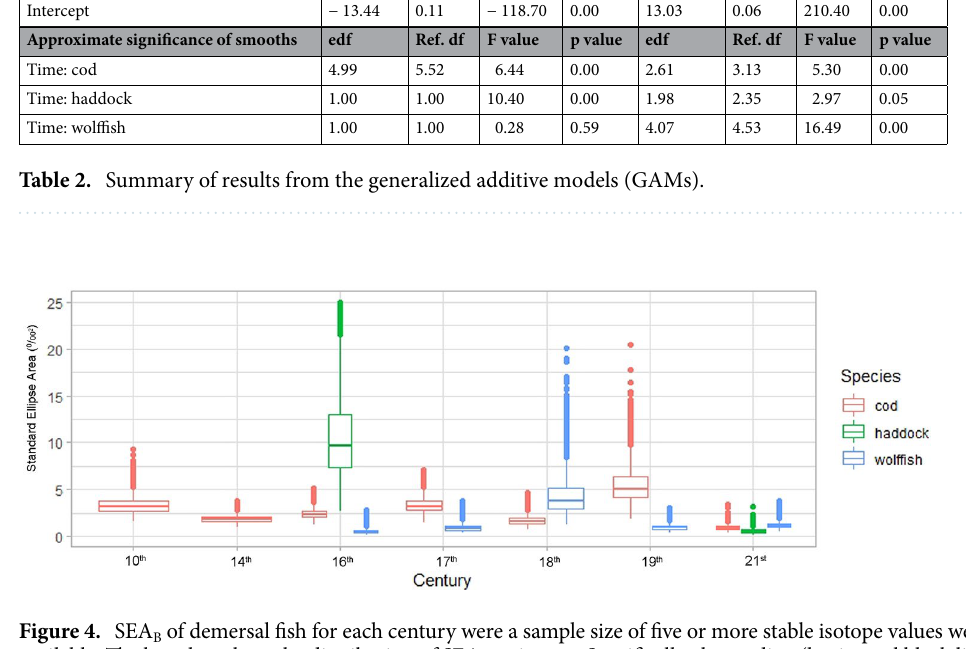
Figure 4. SEA B of demersal fish for each century were a sample size of five or more stable isotope values were available. The boxplots show the distribution of SEA B estimates. Specifically, the median (horizontal black line). First (box) and third (whiskers) quartile. Values falling out with the third quartile are presented as